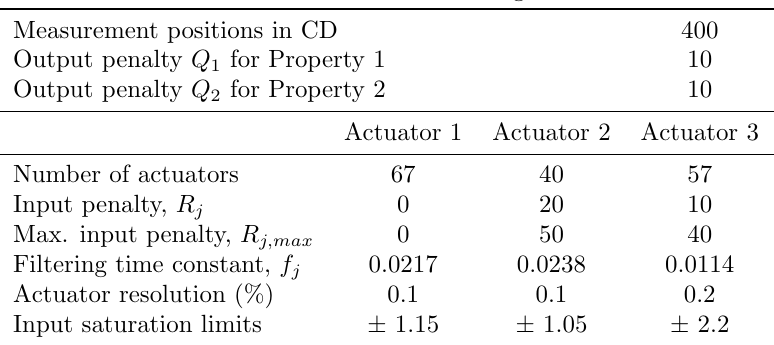
Table 2: Simulation settings.